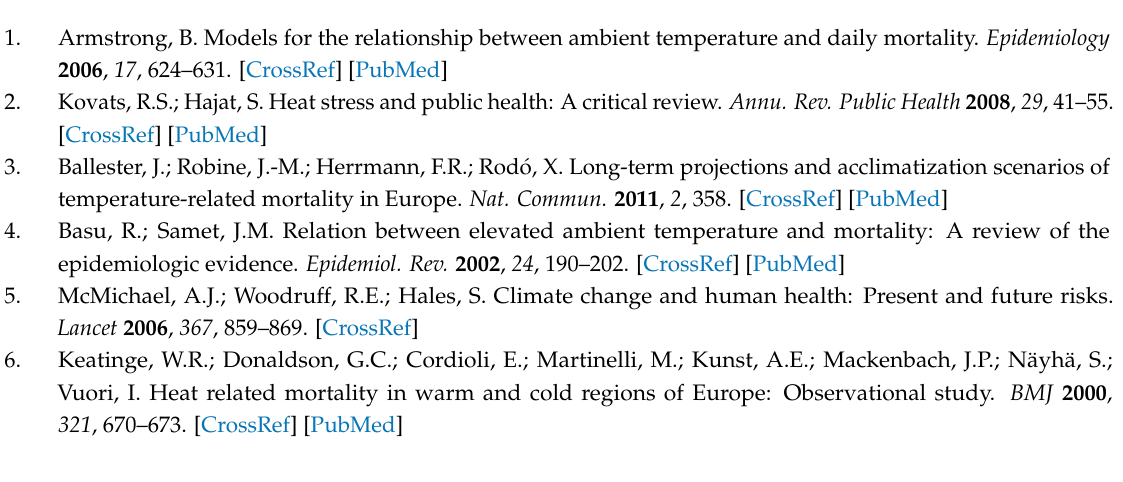
Figure S1: Scatterplots of 7-day mean of relative mortality in different age groups and 7-day mean values of PET at Helsinki-Vantaa airport district in 1972–2014, and two 21-year time periods, 1972–1992 and 1994–2014 and their relationships fitted with the generalized additive model, GAM (95% CI). Figure S2: Scatterplots of 14-day means of relative mortality in different age groups and 14-day mean values of PET at Helsinki-Vantaa airport district in 1972–2014 and two 21-year time periods, 1972–1992 and 1994–014, and their relationships fitted with the generalized additive model, GAM (95% CI). Table S1: 7-day mean values of relative mortality (95% CI) of different age groups in the percentiles of 7-day mean values of PET at Helsinki-Vantaa airport in 1972–2014, and in two 21-year sub-periods, 1972–1992 and 1994–2014, and the statistical significance of the differences in relative mortality between the sub-periods. Table S2: 14-day mean values of relative mortality (95% CI) of different age groups in the percentiles of 14-day mean values of PET at Helsinki-Vantaa airport in 1972–2014, and in two 21-year sub-periods, 1972–1992 and 1994–2014, and the statistical significance of the differences in relative mortality between the